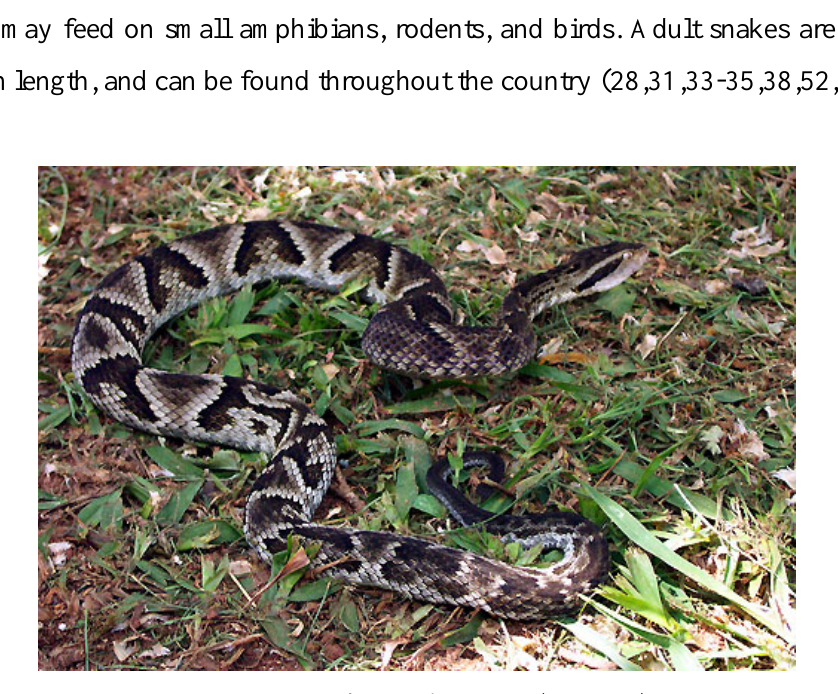
Figure 1. Bothrops jararaca